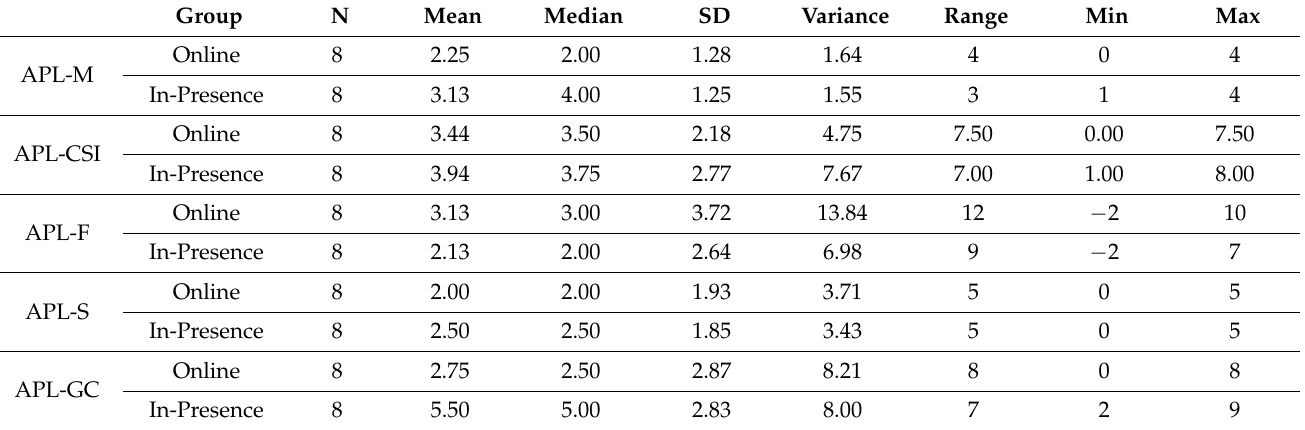
Table 5. Delta values (T1–T0) of behavioral improvements in the Experimental (Online) and Control (In-presence) groups after treatments.